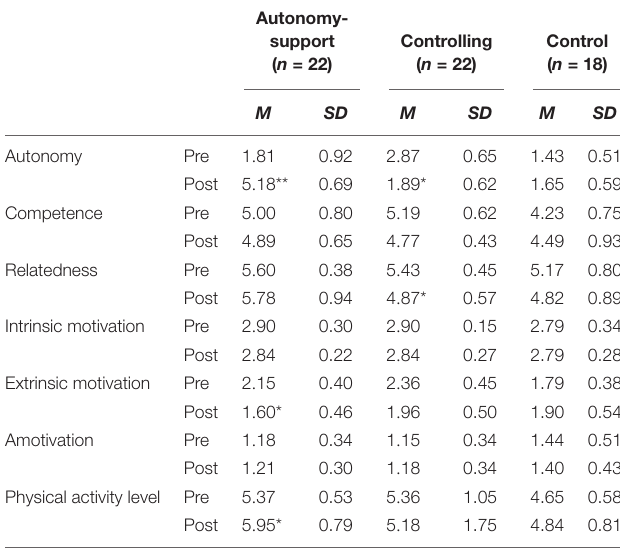
TABLE 2 | Repeated measures analysis between autonomy-supported group, controlling group, and control